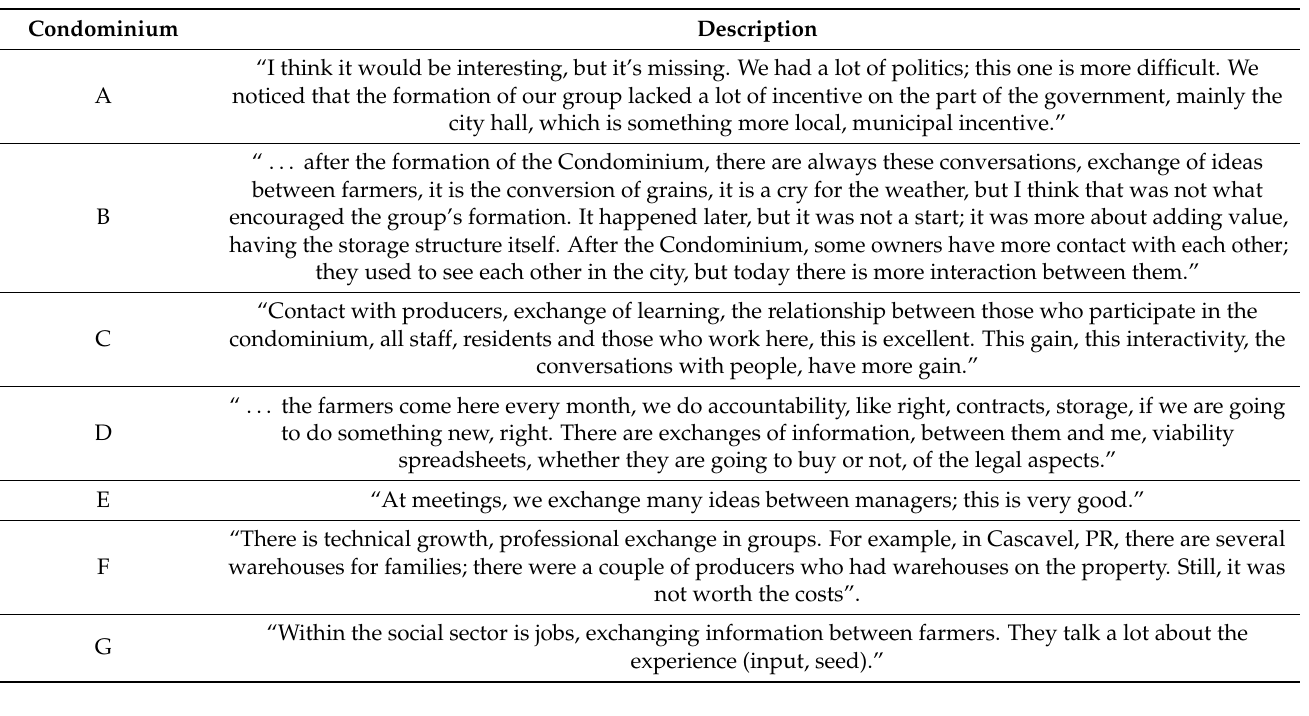
Table 4. Interviewees’ statements about the Social Incentives of the rural collective model Condo- miniums of Rural